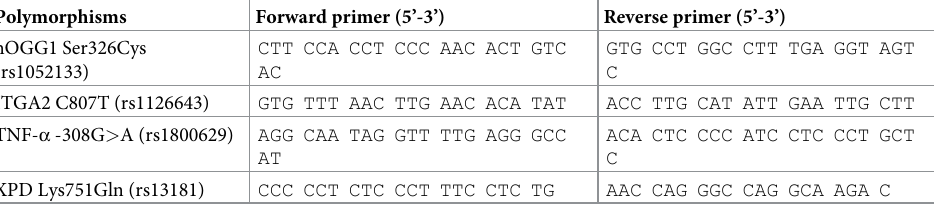
Table 1. Sequence of forward and reverse primers used in